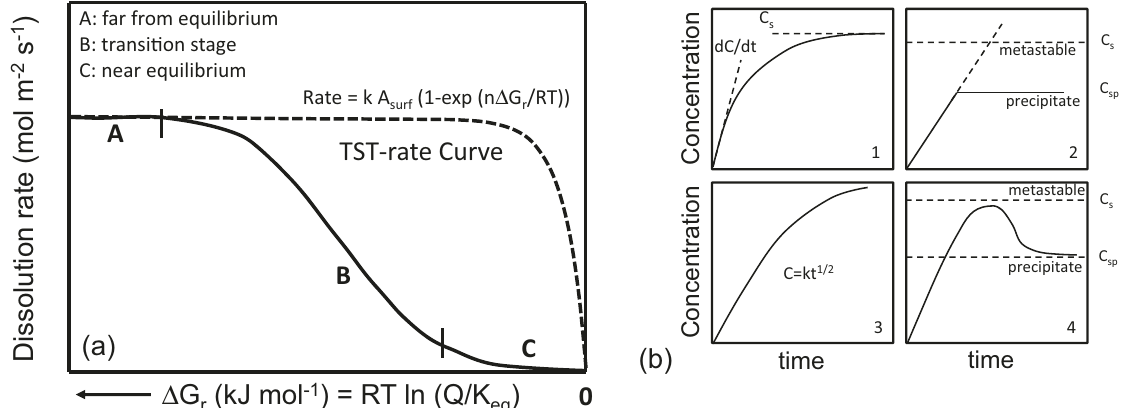
Fig. 2 Schematics of kinetics of crystal dissolution in water. a Dissolution rates as a function of the thermodynamic-driving force Gibbs free energy of the dissolution reaction, Δ G r . A sigmoidal relationship can be characterized by three distinct regions: a dissolution plateau above a critical undersaturation for conditions far from equilibrium (stage A); a transition regime in which the dissolution rate is reduced substantially with less undersaturation (stage B); and a slow dissolution rate close to equilibrium (stage C). The transition-state theory rate is included for comparison, showing a signi fi cant deviation of the dissolution rate near equilibrium. b Phenomenological description of crystal dissolution kinetics in water. Solution concentration – time curves for different dissolution mechanisms: (1) transport controlled mechanism and saturation concentration approaching equilibrium; (2) linear kinetics far from equilibrium and truncated by saturation concentration with respect to a precipitate phase with rapid precipitation kinetics; (3) diffusion controlled kinetics showing a parabolic rate law with the formation of alteration layers; and (4) dissolution with precipitation of a product phase with a sluggish precipitation kinetics. C is the concentration of dissolved species; C s is the concentration of dissolved species under saturated conditions; C sp is the concentration of dissolved species with respect to the secondary precipitate. ( a adapted with permission from ref. 95 , copyright Elsevier 2006) ( b adapted with permission from ref. 96